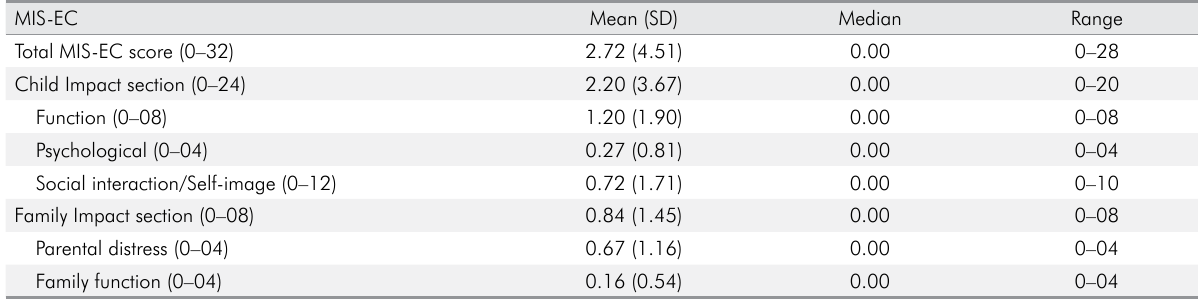
Table 2. Mean, standard deviation (SD), median and range of MIS-EC scores (n = 381).